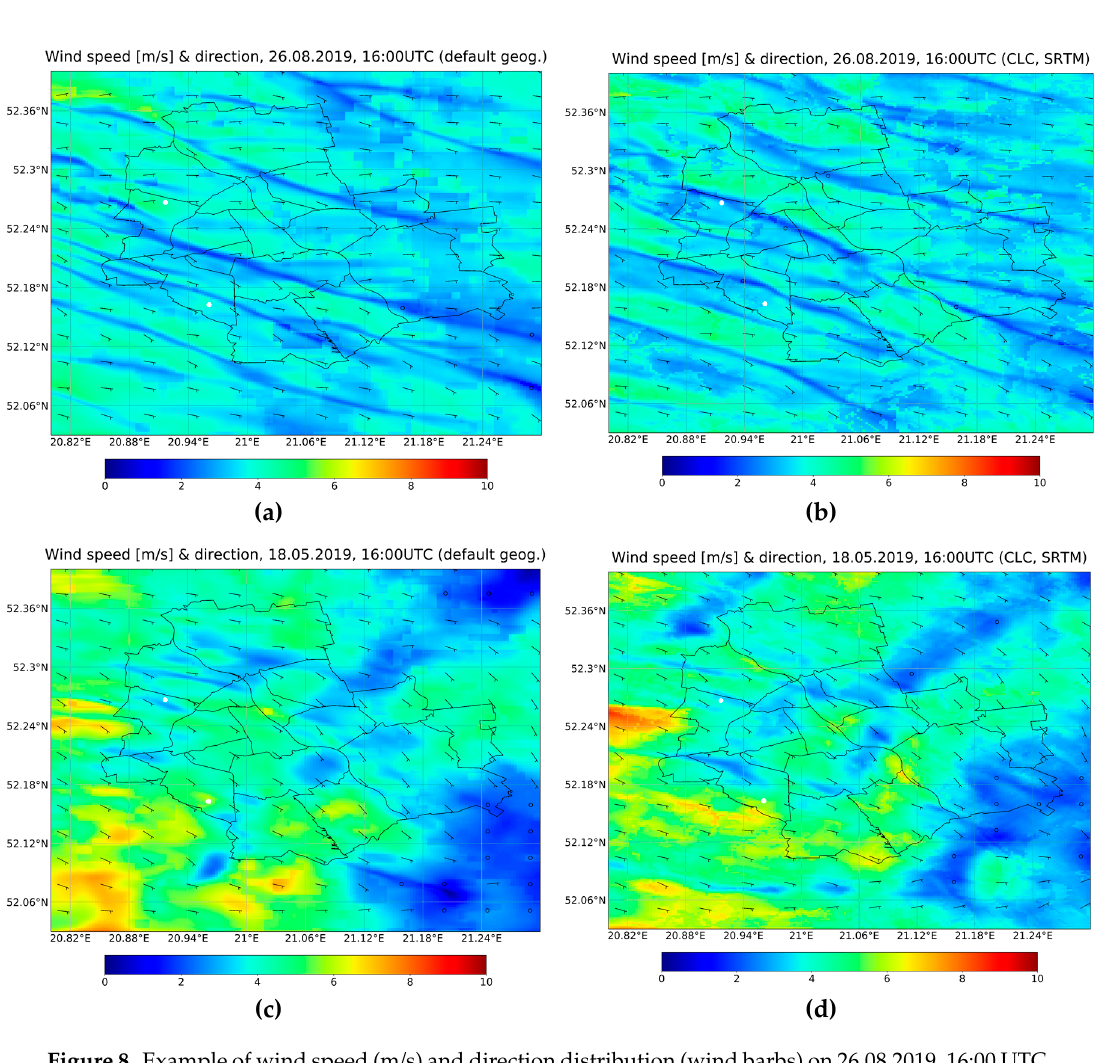
Figure 8. Example of wind speed (m/s) and direction distribution (wind barbs) on 26.08.2019, 16:00 UTC obtained with ( a ) default geographical data; ( b ) CLC and SRTM geographical data. Example of wind speed (m/s) and direction distribution (wind barbs) on 18.05.2019, 16:00 UTC obtained with ( c ) default geographical data; ( d ) CLC and SRTM geographical data.